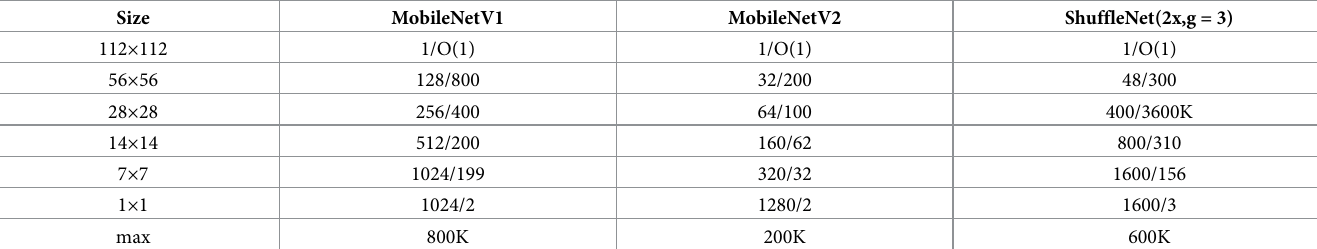
Table 3. The compared sizes for each resolution between MobileNetV1, MobileNetV2 and ShuffleNet.